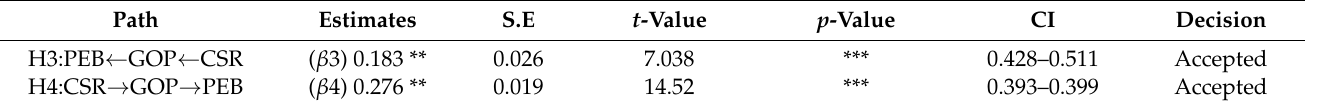
Table 6. Mediation and conditional